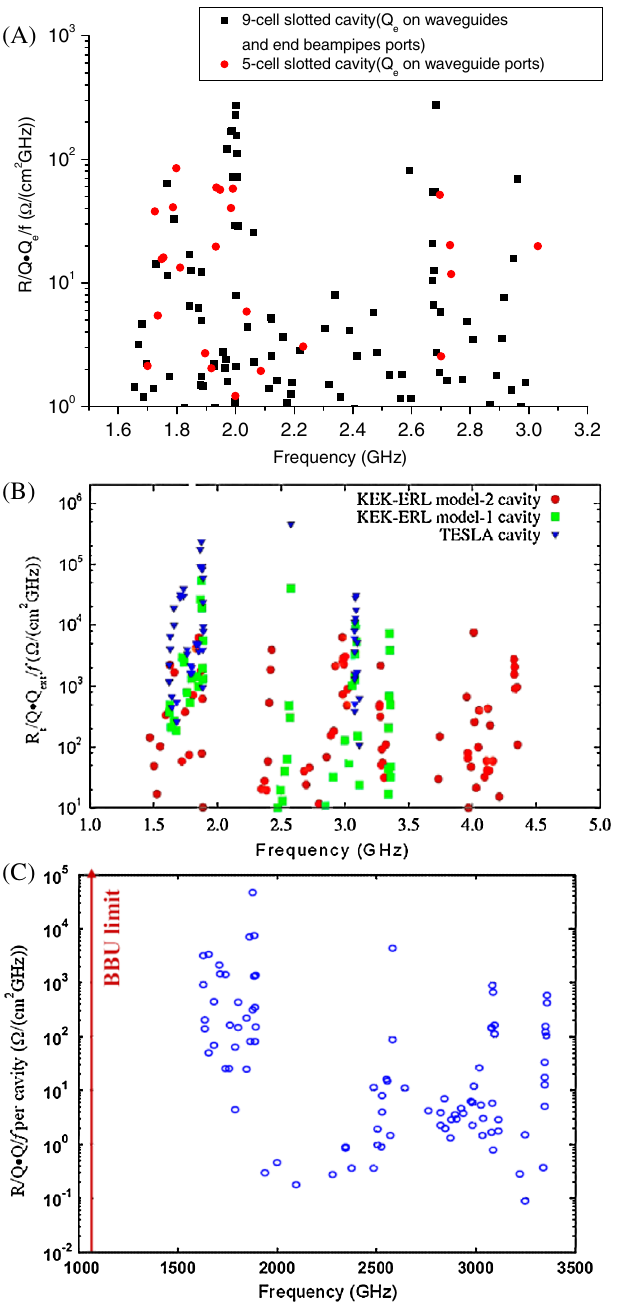
FIG. 13. (Color) Comparison of the quadrupole modes for two different cavities: (A) Slotted cavity; (B) Cornell seven-cell cavity